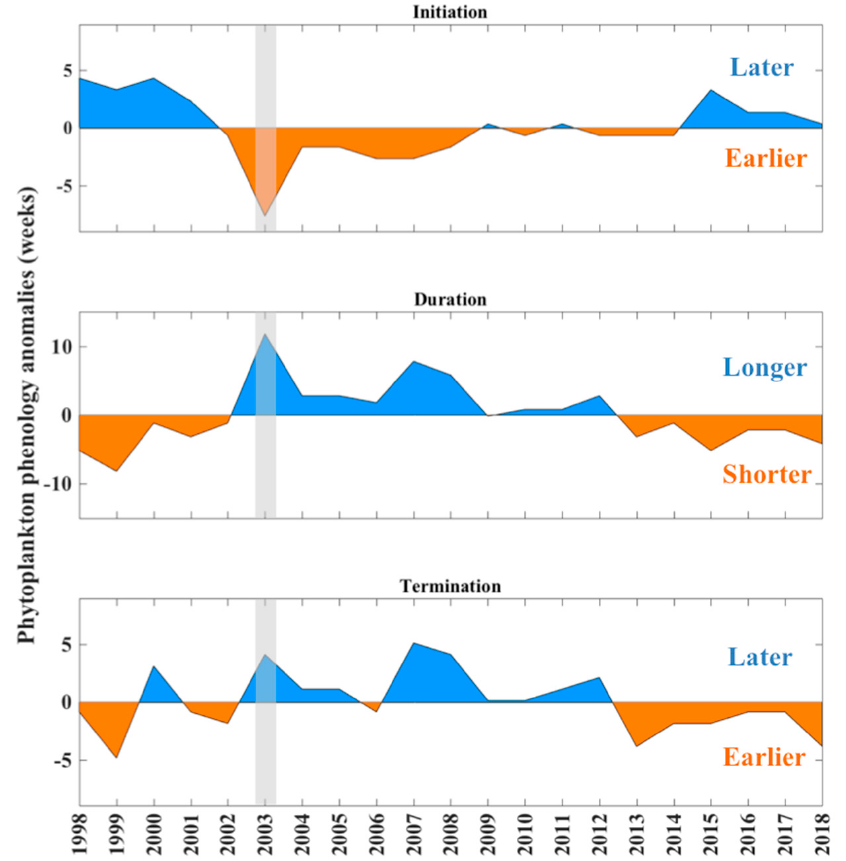
Figure 2. Interannual phenology anomalies (weeks) of the nano/micro-phytoplankton assemblage (timings of the winter bloom initiation, duration, and termination) between 1998 and 2018. The grey shaded bar highlights the event that occurred during the winter blooming period of